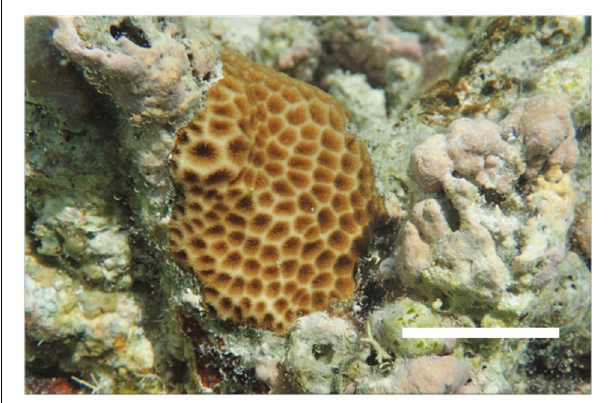
FIGURE 1 | Adult colony of Leptastrea purpurea in its typical habitat. Scale bar: 3 cm.